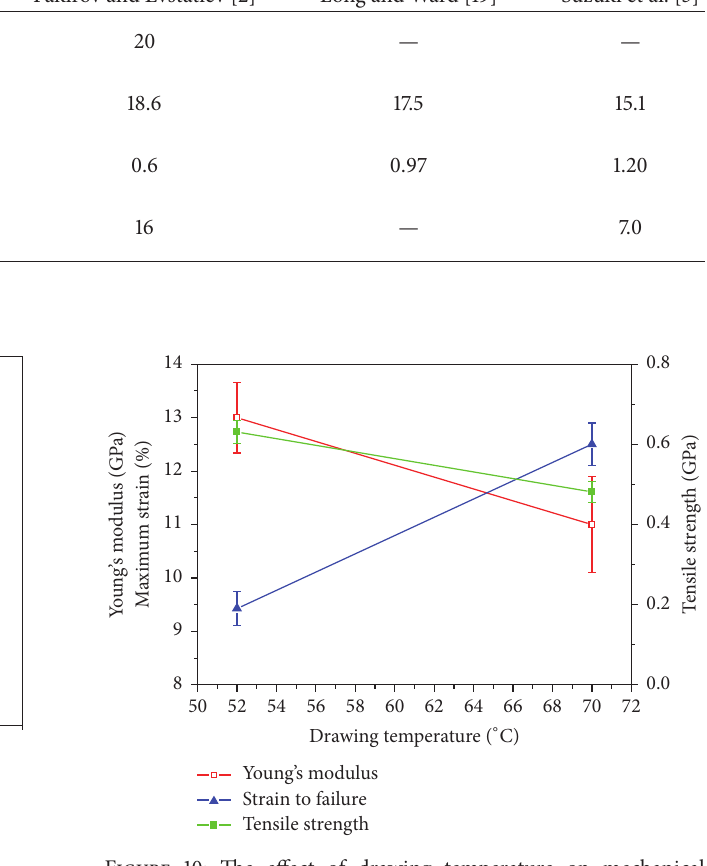
Figure 9: DSC heating traces of solid-state drawn PET, showing the degree of crystallinity after the first and second drawing stages.